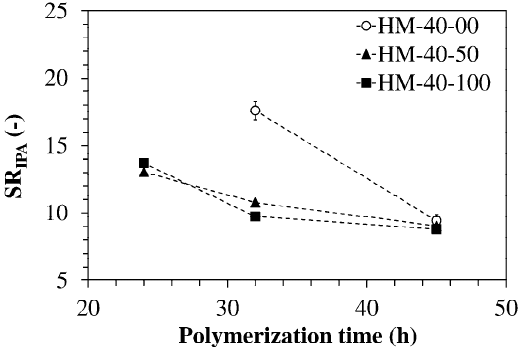
Figure 3. Variation of the equilibrium swelling ratio in IPA with the polymerization time at 80 °C (no crosslinking observed for HM-40-00 in 24 h). Each datum represents the average of four replicates. in the other monomers, but they became gradually transparent as the reaction proceeded.